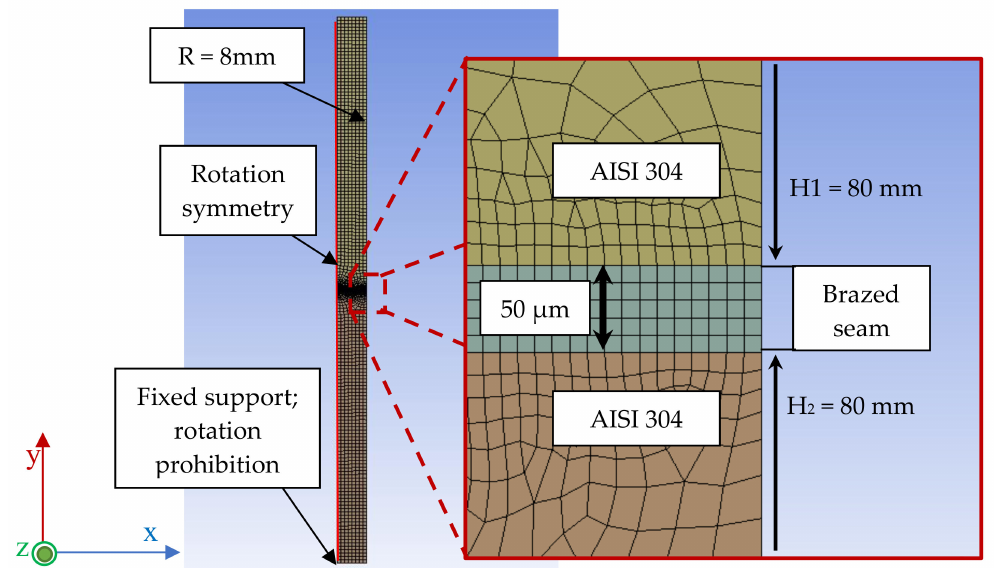
Figure 5. Model of the cylindrical brazed specimen based on the hypothesis of the axis symmetry of the brazed